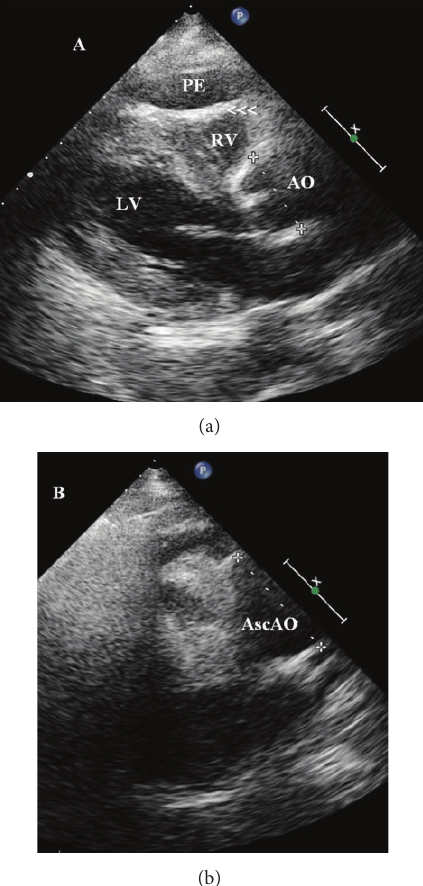
Figure 2: Transthoracic echocardiogram in parasternal long axis view showing moderate pericardial effusion with diastolic collapse of right ventricle (A, arrowheads) in a patient with ascending aortic dissection. Note markedly dilated ascending aorta (B, 5.9 cm). LV: left ventricle; RV: right ventricle; AO: aorta; PE: pericardial effusion; AscAo: ascending